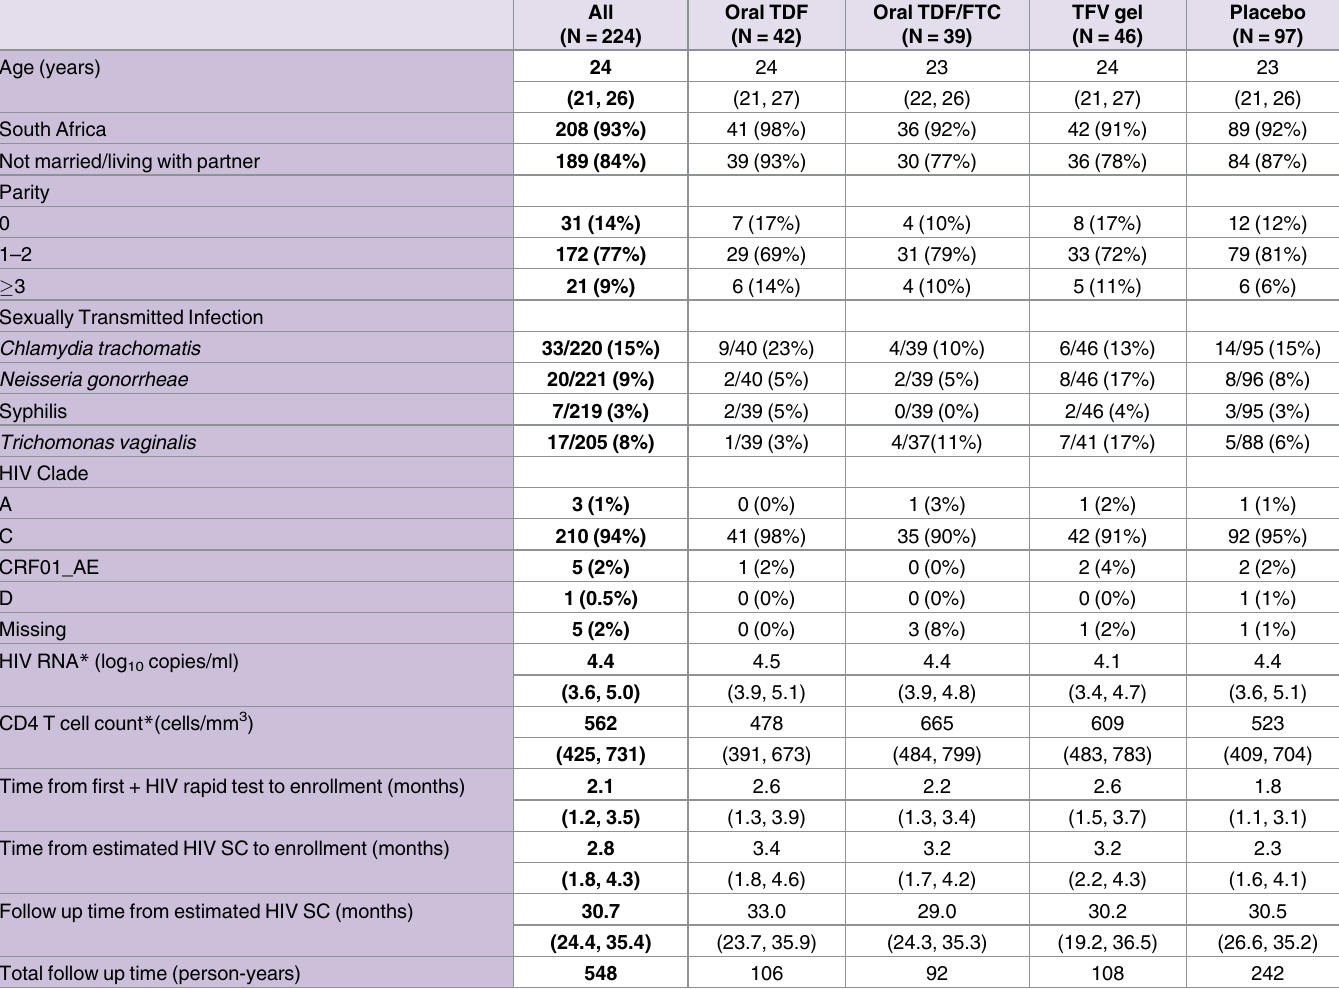
Table 1. Baseline characteristics of the study participants at enrollment into